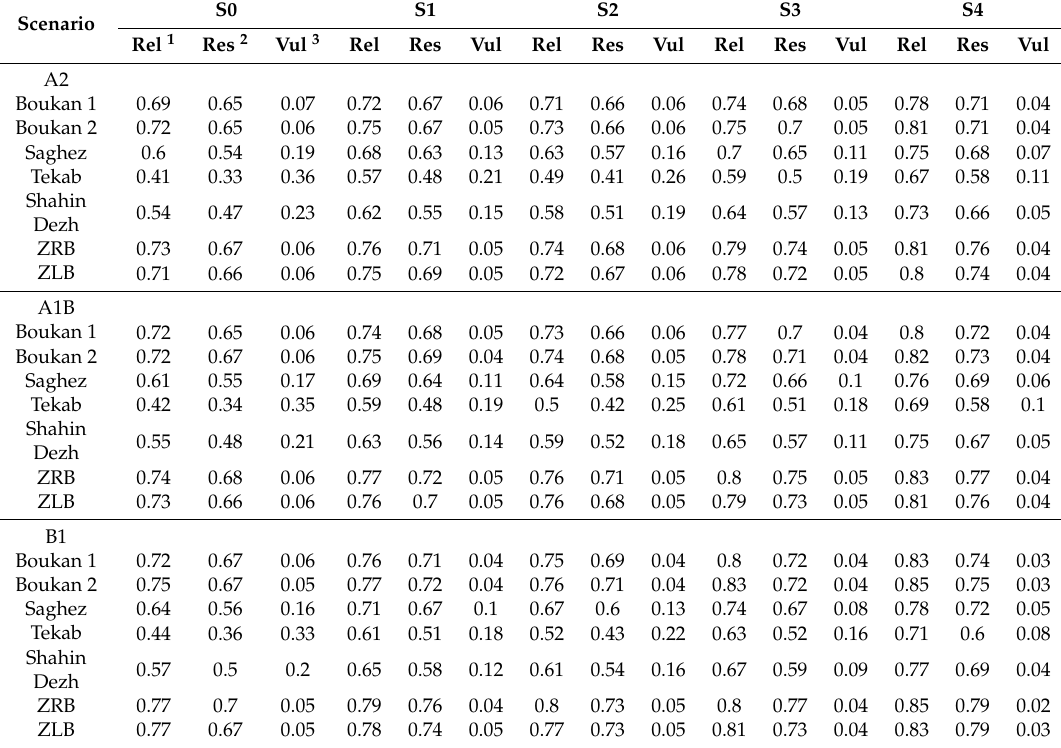
Table 4. Performance criteria of reliability, resilience and vulnerability for agriculture catchments.